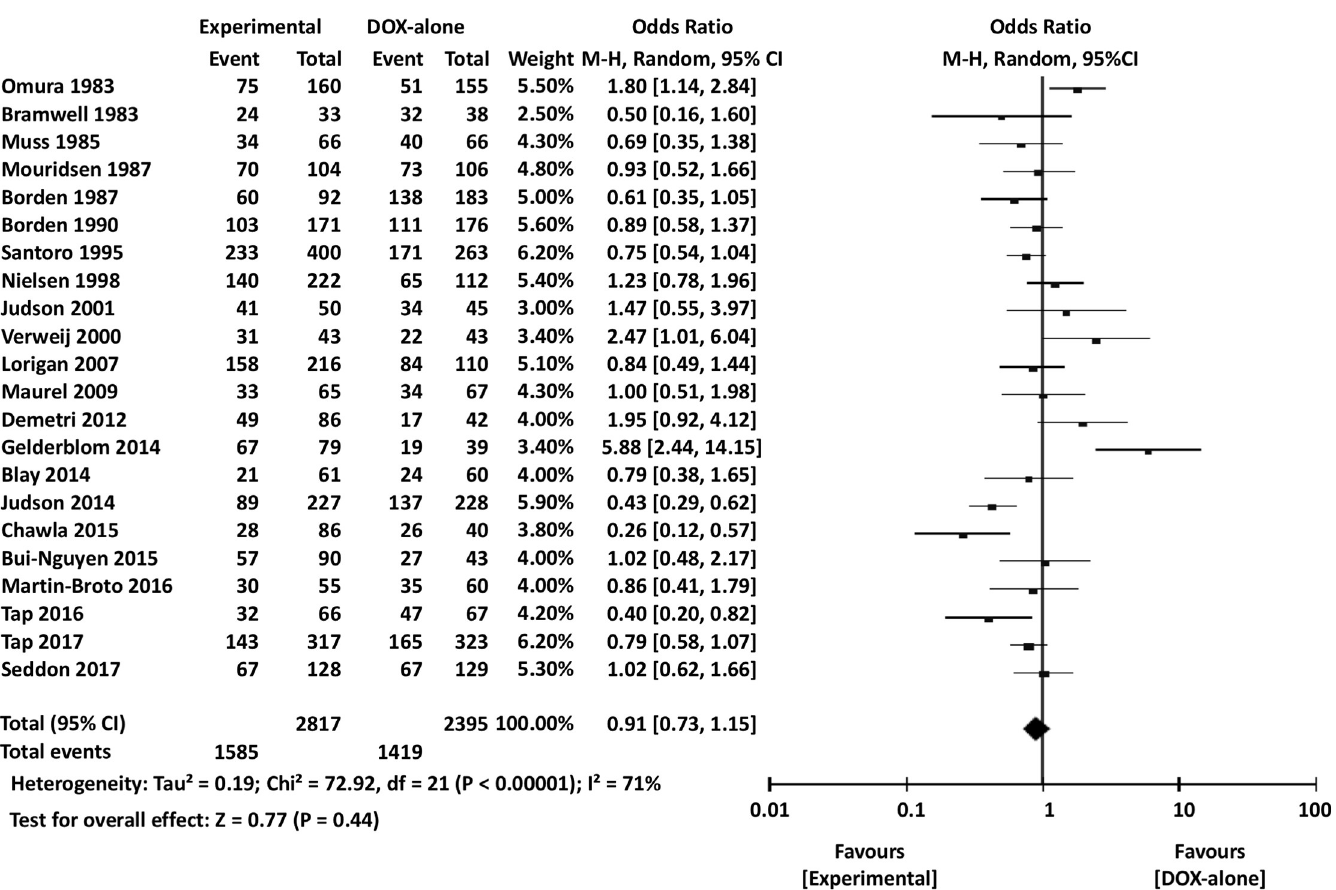
Fig 6. Comparisons of doxorubicin alone vs experimental chemotherapy: Forest plots of 6-month progression-free survival. CI, confidence interval; M-H, Mantel-